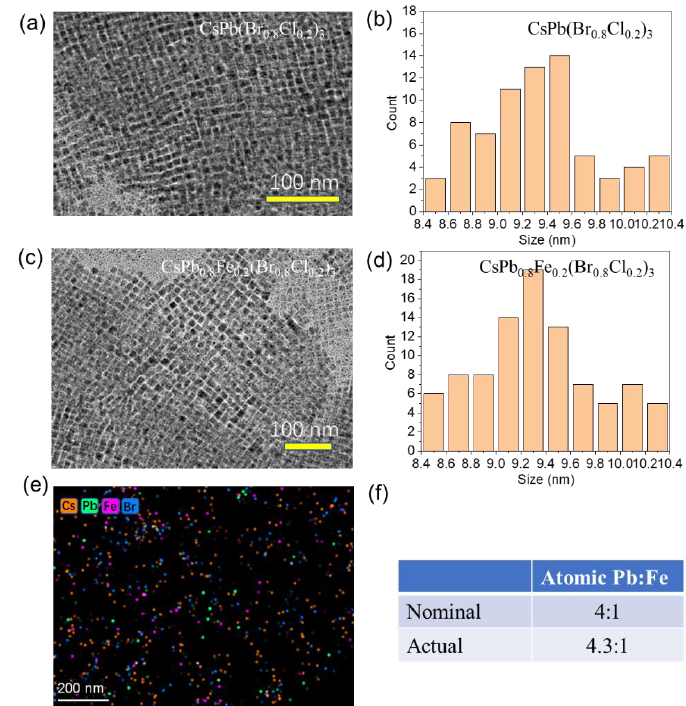
Figure 1. ( a , b ) TEM image ( a ) and size distribution ( b ) of the CsPb(Br 0.8 Cl 0.2 ) 3 NCs. ( c , d ) TEM image and size distribution of the CsPb 0.8 Fe 0.2 (Br 0.8 Cl 0.2 ) 3 NCs. ( e ) Elemental mappings of the CsPb 0.8 Fe 0.2 (Br 0.8 Cl 0.2 ) 3 NCs. ( f ) Atomic ratio between Pb and Fe of the CsPb 0.8 Fe 0.2 (Br 0.8 Cl 0.2 ) 3 NCs.